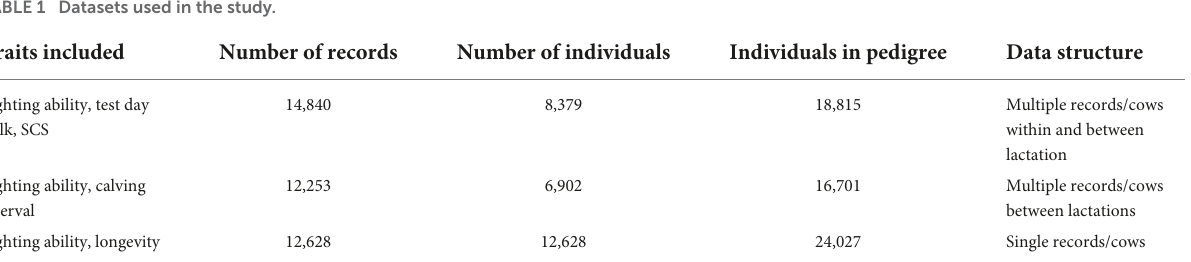
TABLE 1 Datasets used in the study. Traits